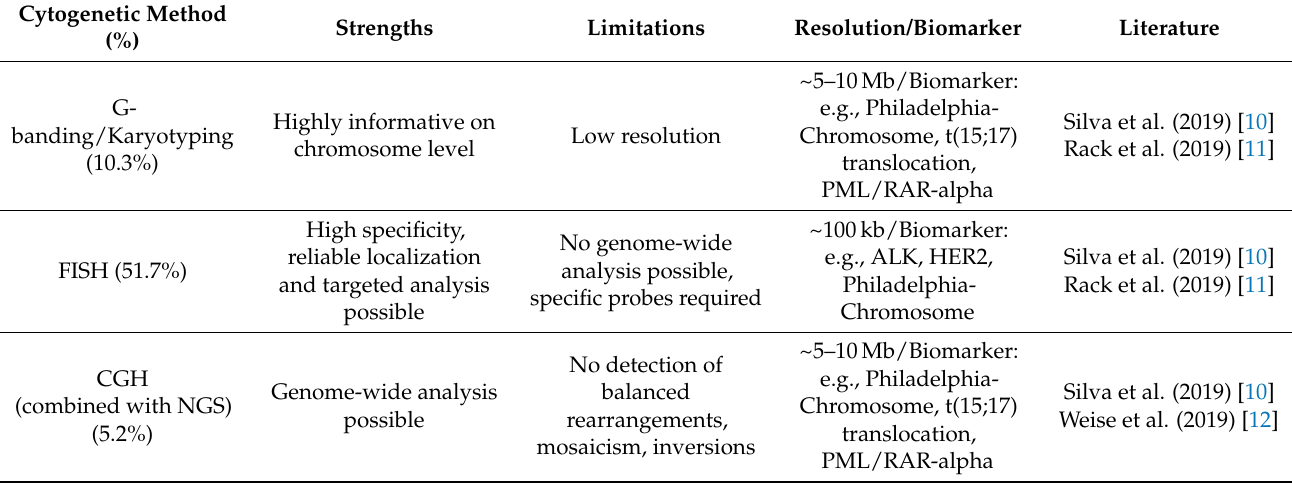
Table 2. Strengths and limitations of GTR-registered cytogenetic tests identified via screening by biomarker for PharmGKB listed drugs with a requirement or recommendation for testing in the EU. CGH: comparative genomic hybridization. Cytogenetic